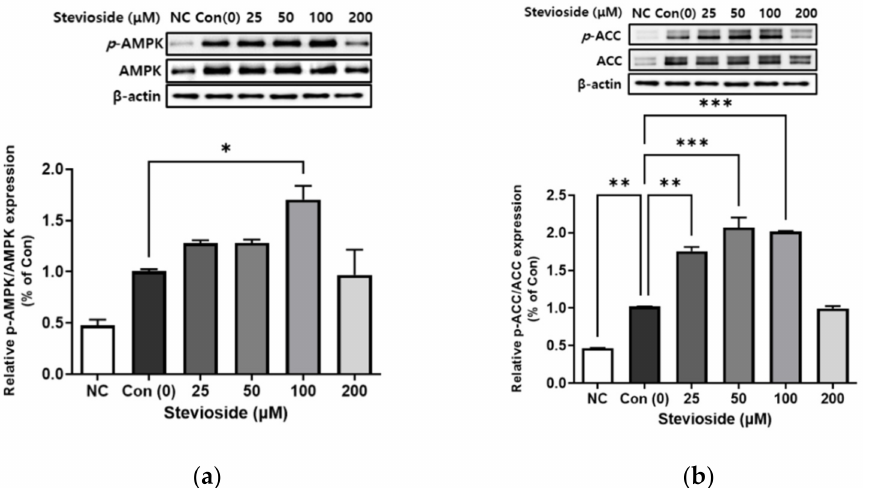
Figure 4. The effect of stevioside on the relative phosphorylation expressions of ( a ) adenosine monophosphate-activated protein kinase (AMPK) ( b ) acetyl-CoA carboxylase (ACC) in 3T3-L1 cells. All data are presented as mean ± SD, and tests were performed in three independent experiments. * p < 0.05, ** p < 0.01 and *** p < 0.001. Negative control (NC) was not treated with an adipocyte differentiation